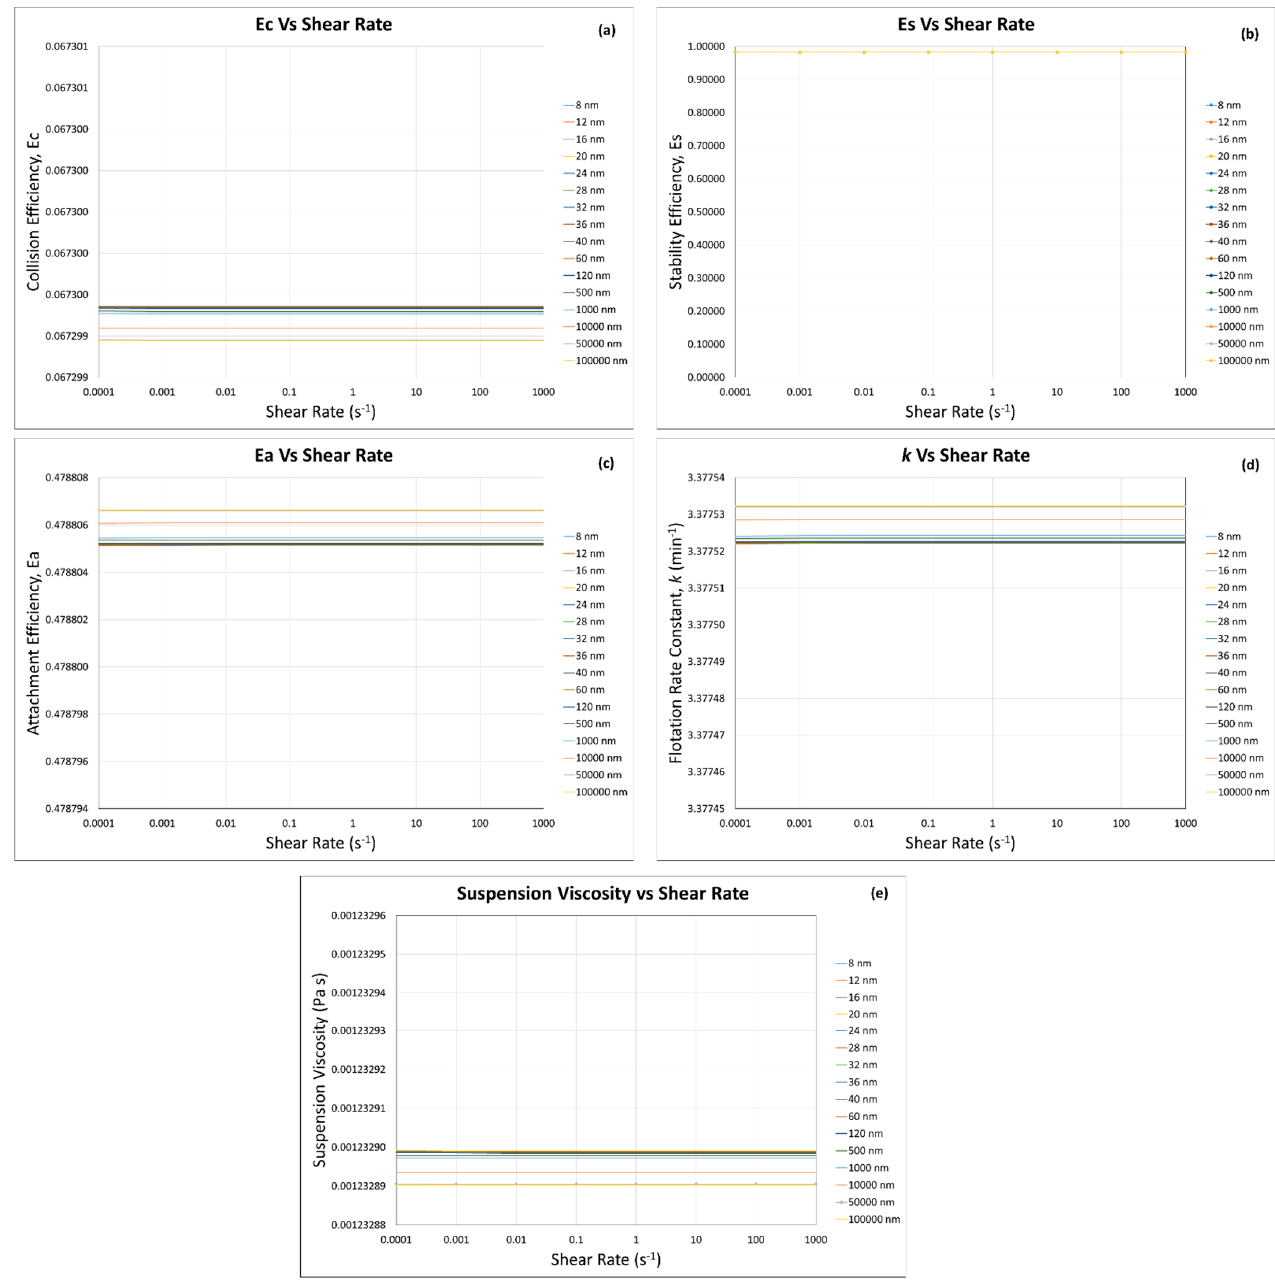
Figure 12. Flotation efficiencies: ( a ) collision, ( b ) stability, ( c ) attachment, and ( d ) rate constant by using ( e ) the suspension viscosity calculated by the predictive model (same particles with different sizes ( 𝑎 (cid:2869) : 𝑎 (cid:2870) = 9: 1 ), at 𝜙 = 0.1 ).